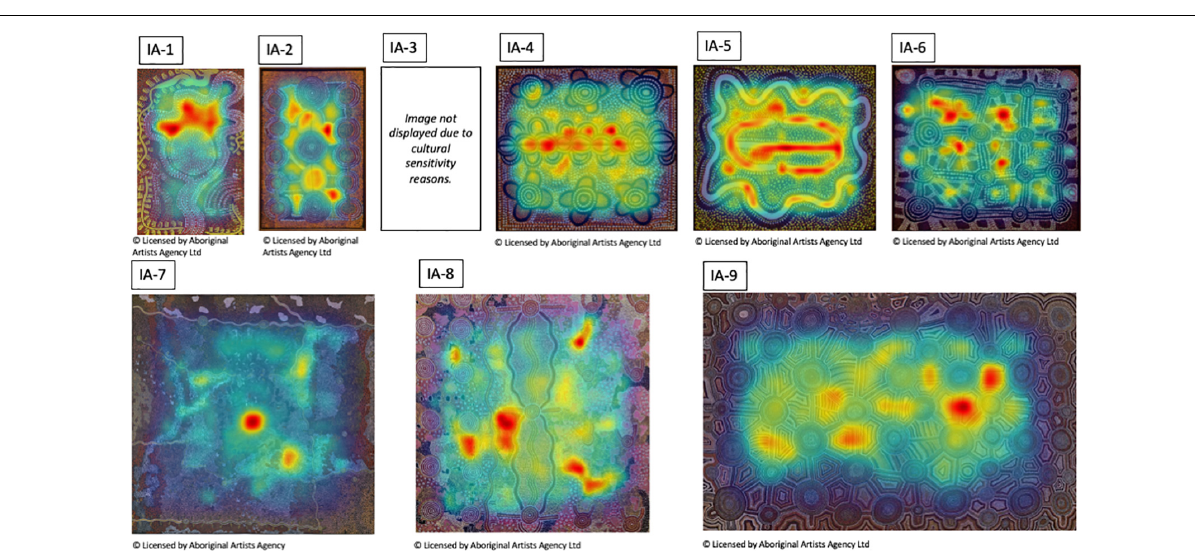
FIGURE 13 | Graph-based Visual Saliency maps (Harel et al., 2007) for the Indigenous Australian